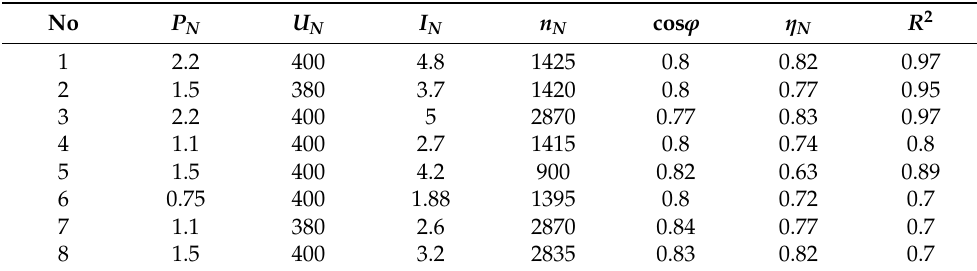
Table 2. The rated data of selected